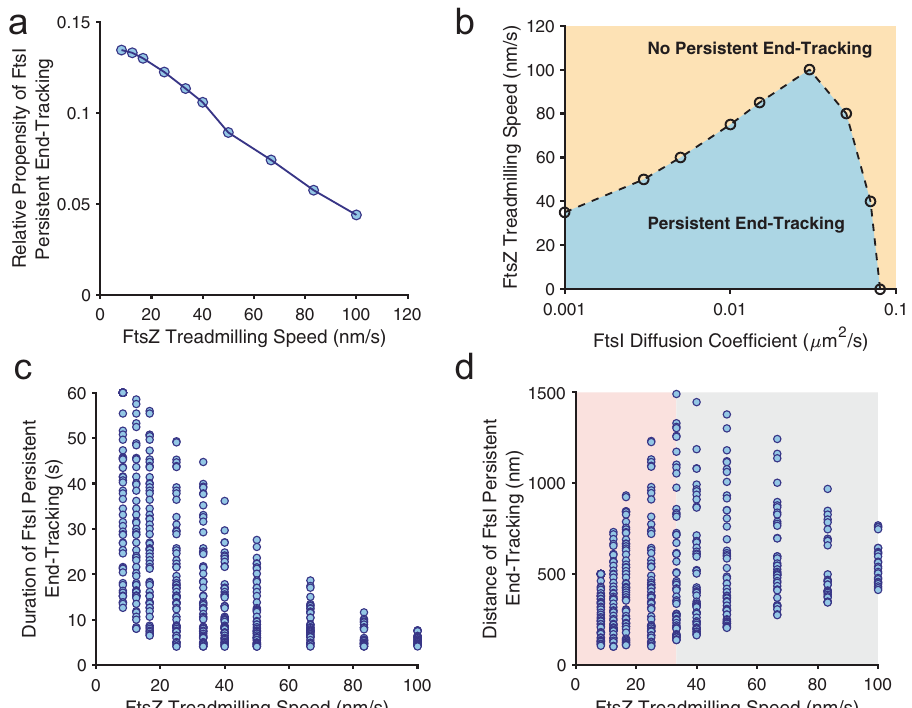
Fig. 3 Model predictions for the processivity of FtsI directional movement modulated by FtsZ treadmilling speed. a Predicted relative propensity of FtsI persistent end-tracking as a function of FtsZ ’ s treadmilling speed. For each FtsZ treadmilling speed, 100 independent stochastic FtsI trajectories were simulated, from which the number of FtsI persistent end-tracking trajectories were counted. In line with our experimental measurements, the criteria for persistent end-tracking were as follows: (1) the distance between the FtsZ shrinking end and FtsI is less than 100 nm and (2) FtsI persistently follows the FtsZ shrinking end for greater than 4 s. A total of 664 out of 1000 simulated FtsI trajectories were scored as persistent end-tracking, and the number of trajectories at each FtsZ treadmilling speed was normalized as a relative probability of end-tracking . b Calculated phase diagram of FtsI persistent end- tracking characterized by FtsI diffusion constant and FtsZ treadmilling speed . c Predicted FtsZ treadmilling speed-dependence of the duration of FtsI persistent end-tracking. d Predicted FtsZ treadmilling speed-dependence of run distance of FtsI persistent end-tracking. The shaded regions emphasize the rise and decay of the maximum persistent run distance dependent on FtsZ ’ s treadmilling speed. For the model calculations in a – d , the FtsZ – FtsI binding potential is set to be 10 k B